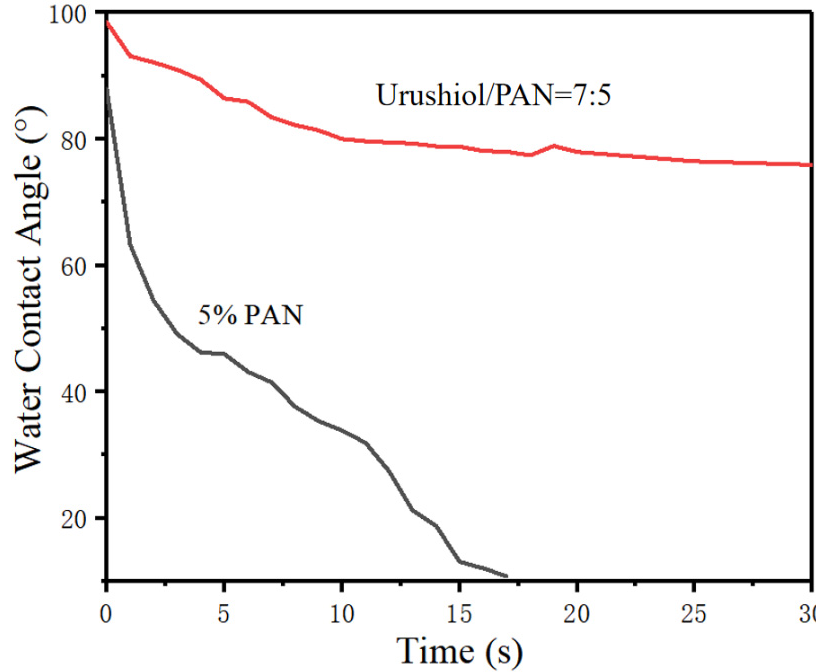
Figure 8. Water contact angle test results of nanoscale urushiol/PAN and PAN films. Table 3. Tensile strength results of urushiol/PAN nanofilms.